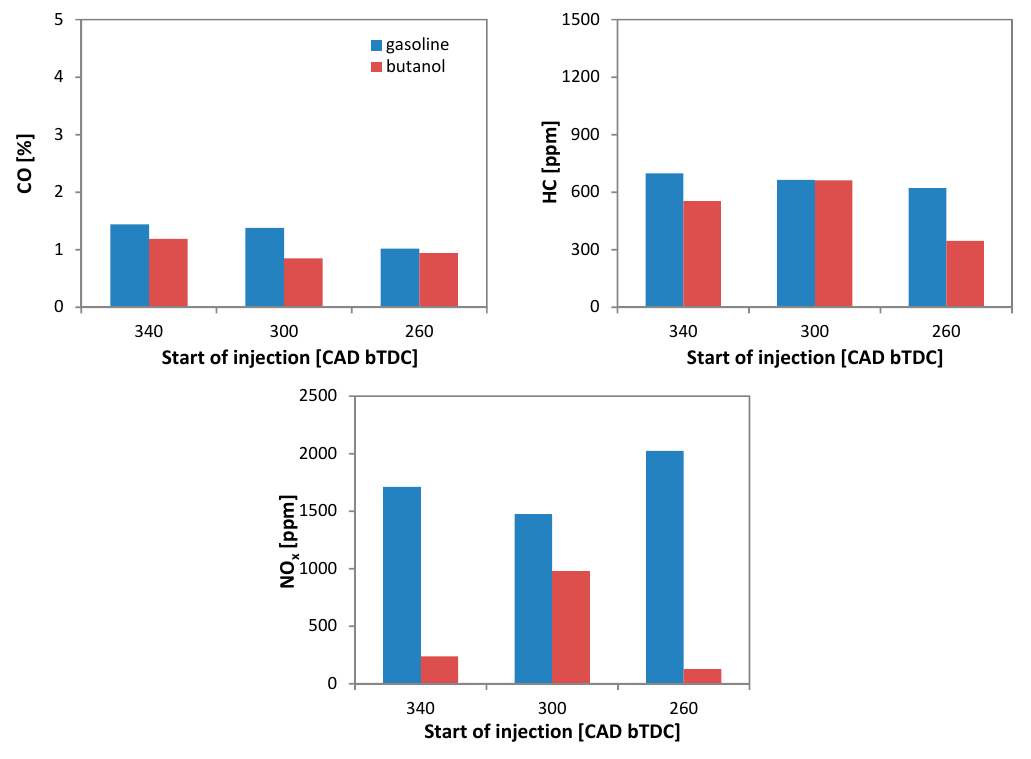
Figure 6. Exhaust gas emissions for the two fuels.